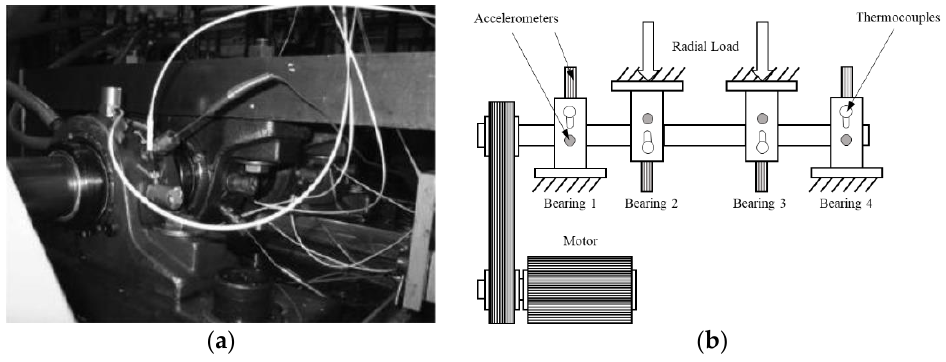
Figure 5. ( a ) Test rig of IMS dataset. ( b ) Illustration of IMS test rig.